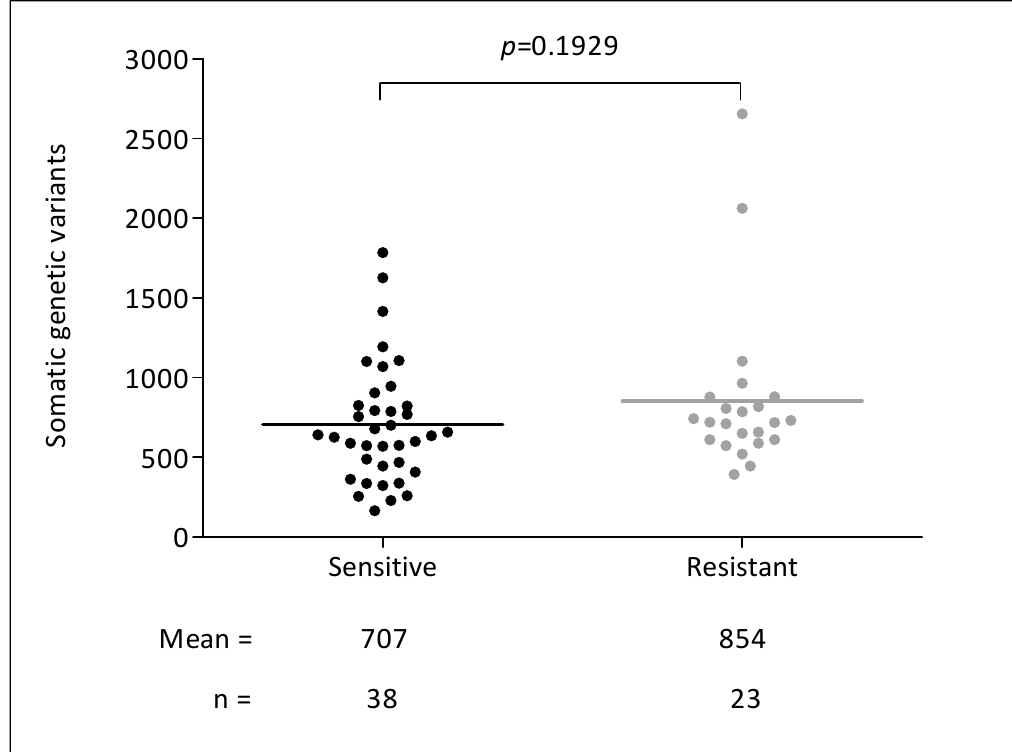
Figure 2. Number of somatic genetic variants and response to anti-EGFR agents.